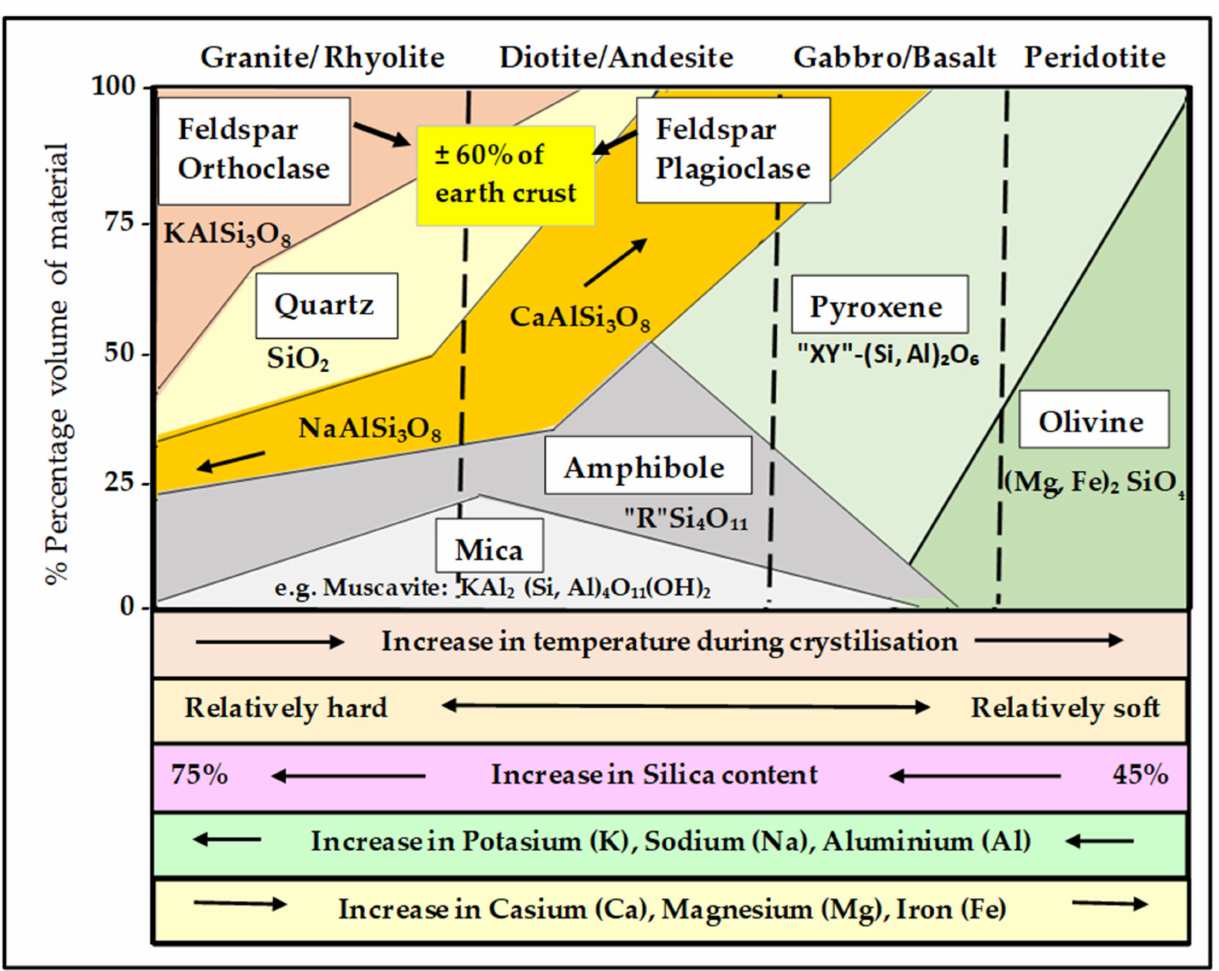
Figure 2. Generalised composition of Igneous rocks found in the crust of the Earth (based on and compiled from various similar figures in public domain, e.g.,